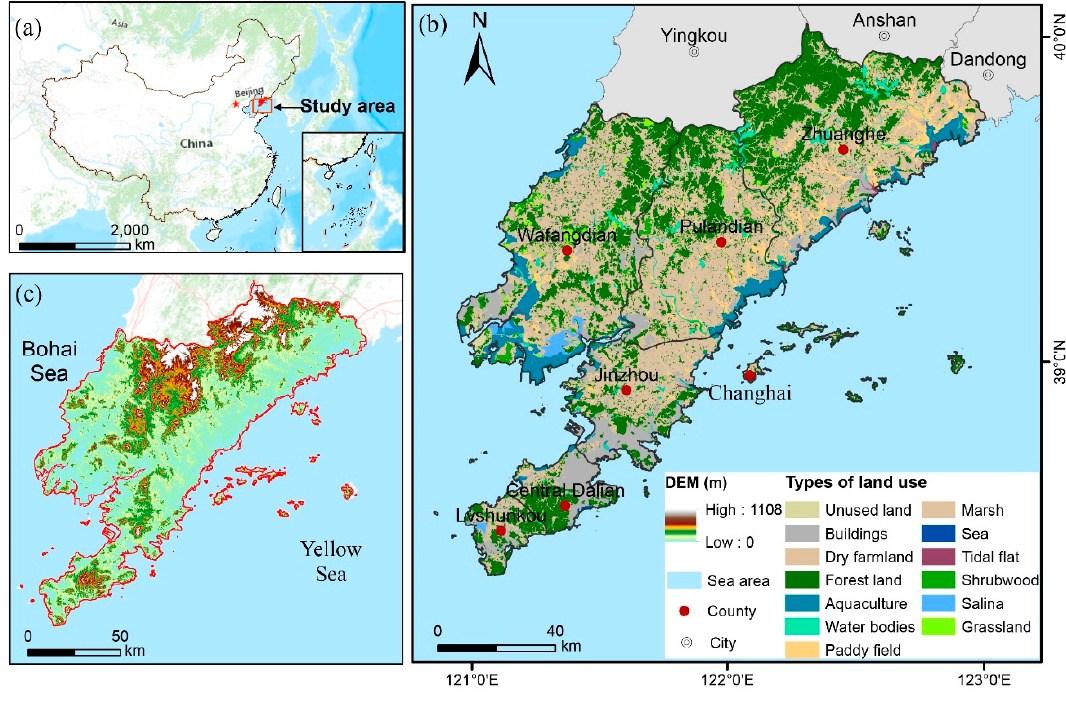
Figure 1. Study area in China ( a ), topography ( b ), and land-use classification in 2015 ( c